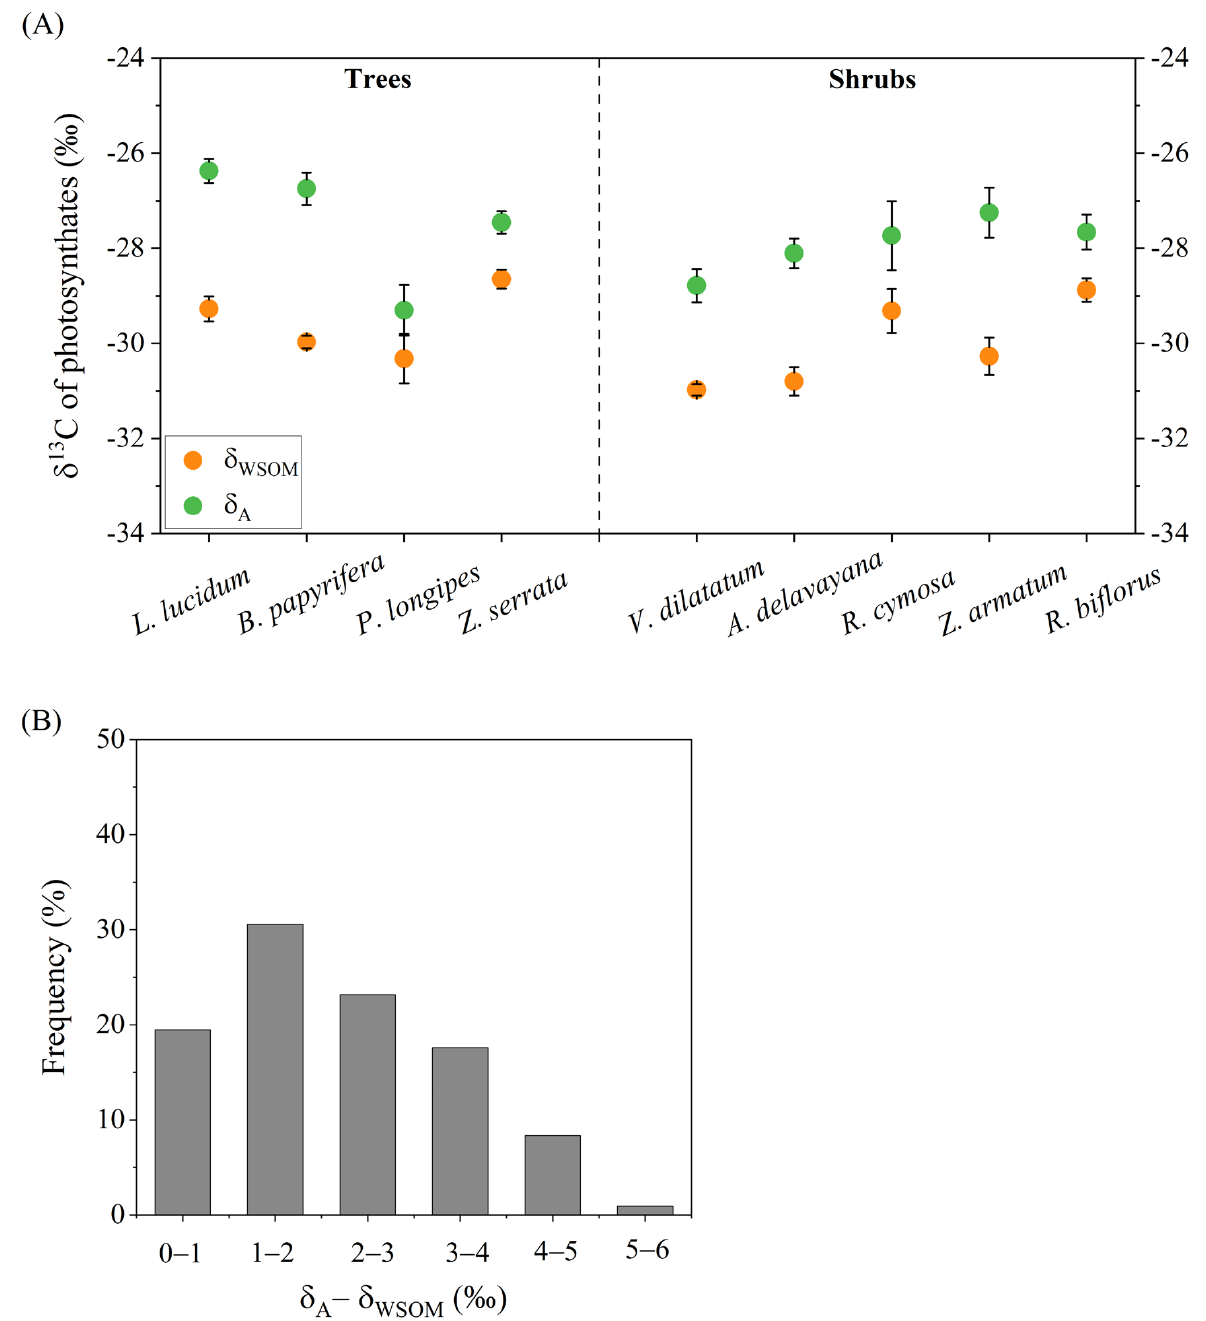
Figure 3. δ 13 C of photosynthates determined by measuring isotope signals of leaf WSOM (orange closed circle) or predicted with Equation (1) that only accounted for assimilation of atmospheric CO 2 (green closed circle) of nine species across three altitudes ( A ); frequency distribution of the discrepancy between δ A and δ WSOM ( B ).